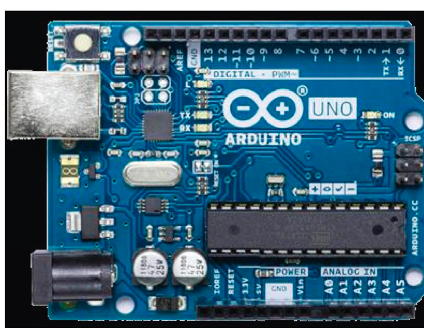
Figure 2: Front view of the